Question: What does this figure show? Answer in one sentence.
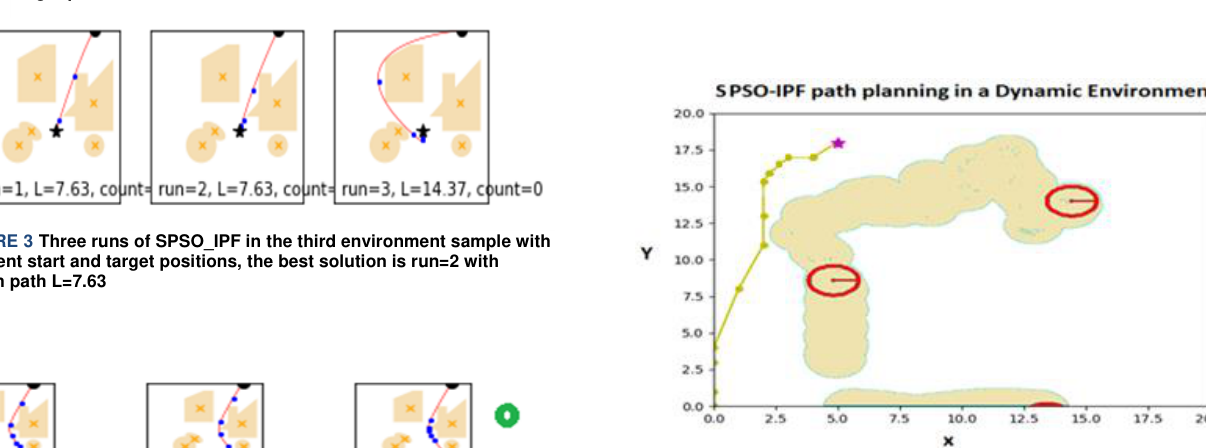
Answer: depicts the path generation performance by the  designed  SPSO-IPF  method.  Since,  for  real-time  applications, one run per epoch is considered, only the  collision avoidance criterion is seen in the generated path,  smoothness and shortest length path criteria do not  significantly play their roles in the generated way.